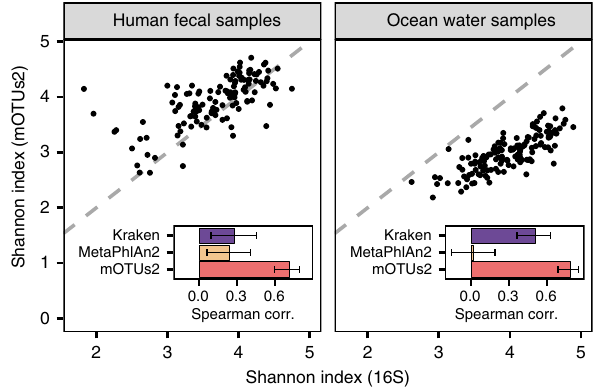
Fig. 3 Reference-extended mOTUs for microbial community diversity pro fi ling. Shannon index was calculated based on 16S rRNA gene (16S) fragments ( x -axis) and mOTUs ( y -axis), respectively, for 129 human faecal samples (left) and 139 ocean water samples (right). Mean Spearman correlation of diversity estimates based on 16S and three metagenomic pro fi ling tools (Kraken, MetaPhlAn2 and mOTUs2) are shown in the insets. Error bars delineate 95% con fi dence intervals after bootstrapping. Source data are provided as a Source Data fi